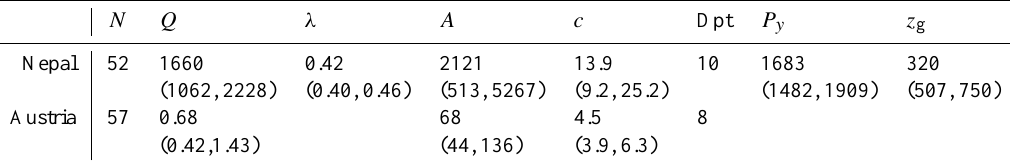
Table 2. Catchment characteristics of the case studies.